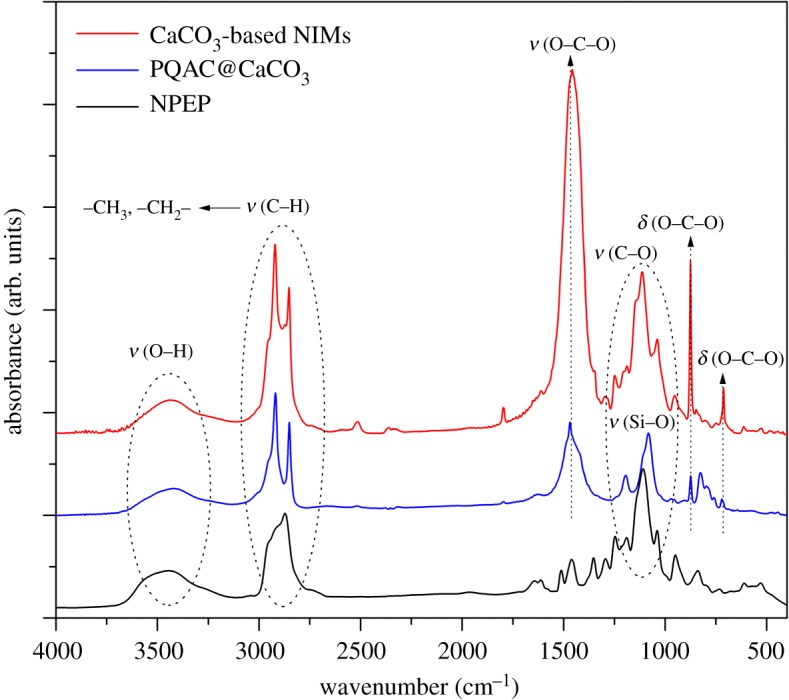
FTIR spectra of CaCO3-based NIMs, PQAC-CaCO3 nanoparticles and pristine NPEP.